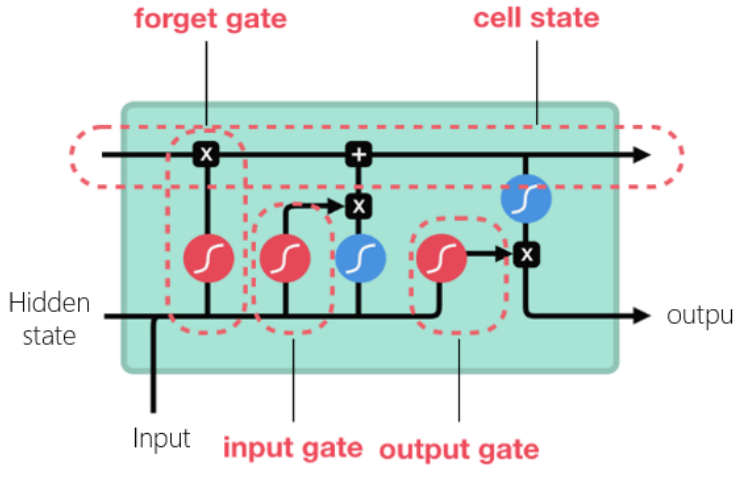
Figure 1. Diagram of an LSTM cell